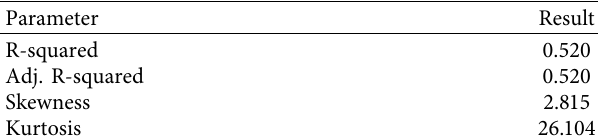
Table 12: Number of passengers in each group.